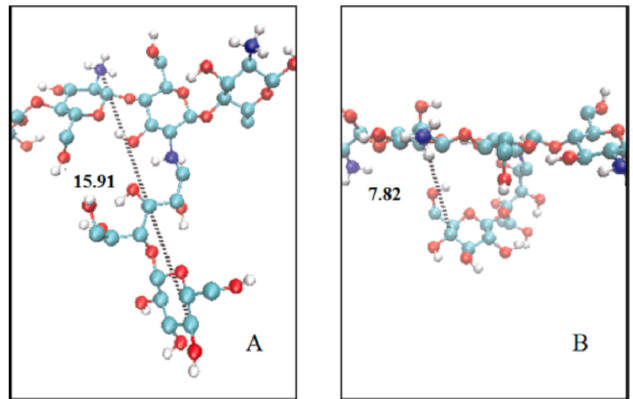
Figure 3. Molecular Dynamics (MD) snapshots showing the orientation of the lactitol side attached to the chitosan backbone in the regions of conformational switches I ( A ) and II ( B ). The distance (in Å) between atom C4l at the far end of lactitol and the N5 atom of the preceding chitosan repeating unit is reported in each case. Reprinted with permission from Phys. Chem. B 2013, 117, 43, 13578–13587. Copyright (2013) American Chemical Society.